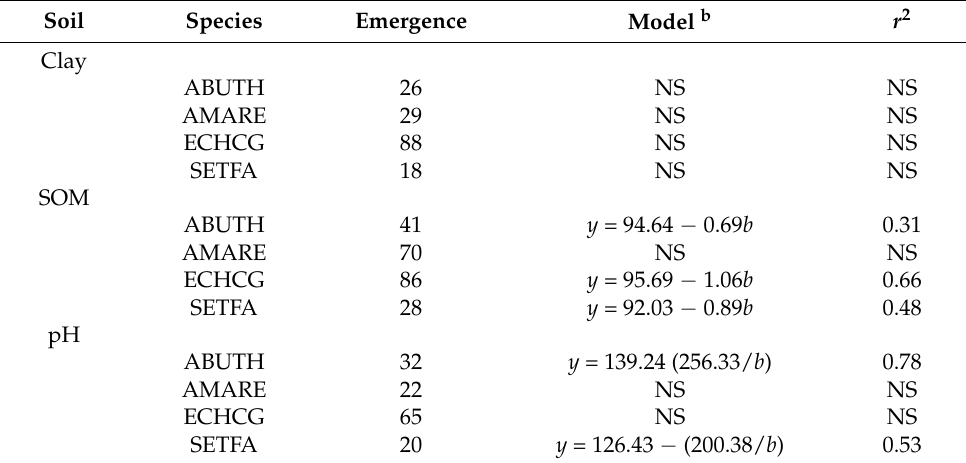
Table 2. Seedling count of weed species averaged by soil and regression equation used to model weed control for clay, SOM and pH soils a .